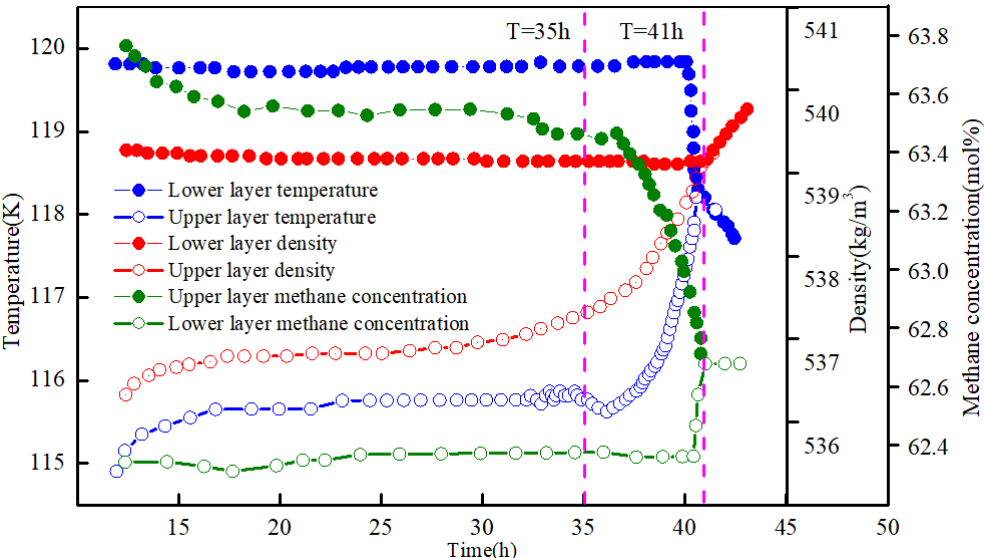
Figure 7. Variations of temperatures, methane concentrations, and densities during La Spezia incident. This figure is adapted from [75].